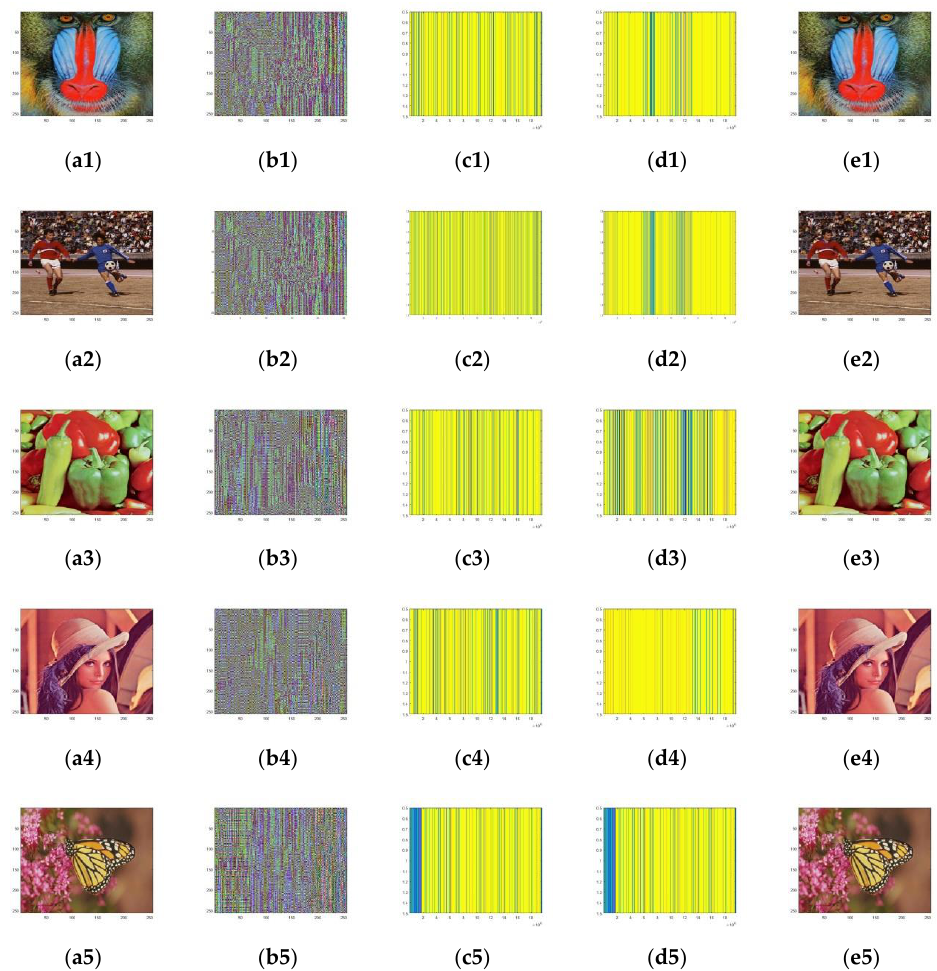
Figure 3. Images from Column 1 to Column 5 are original images, cipher images, retrieved permutation-di ff usion images, retrieved permutation-only images, restored images. Table 2. Execution time